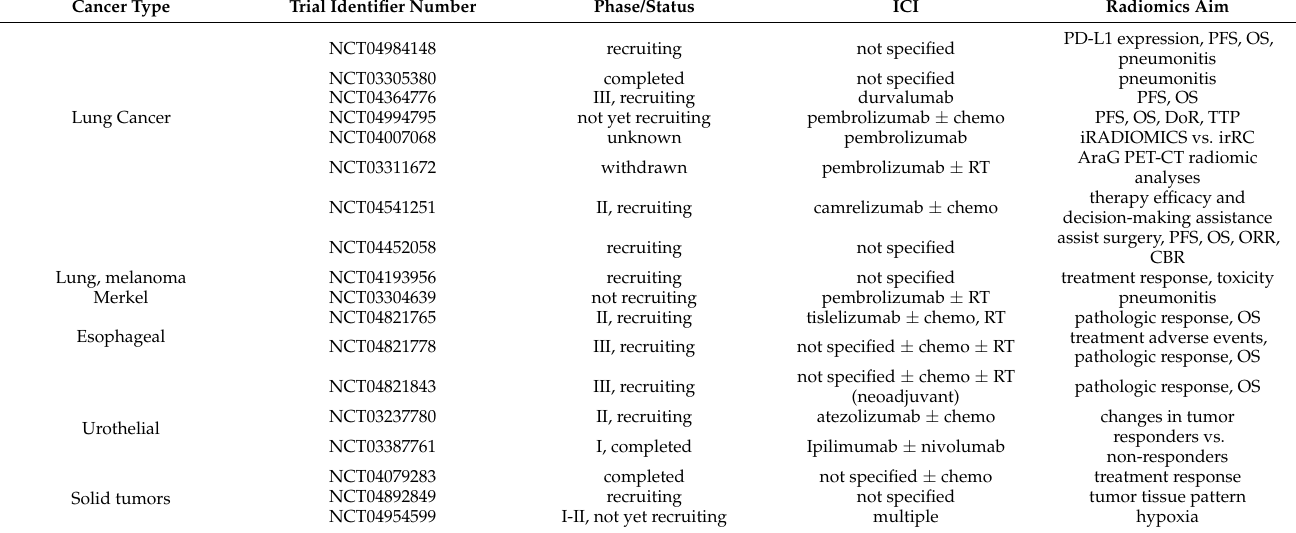
Summary of the ongoing clinical trials with ICI and radiomic analysis (source: https://clinicaltrials.gov/, accessed on 14 February